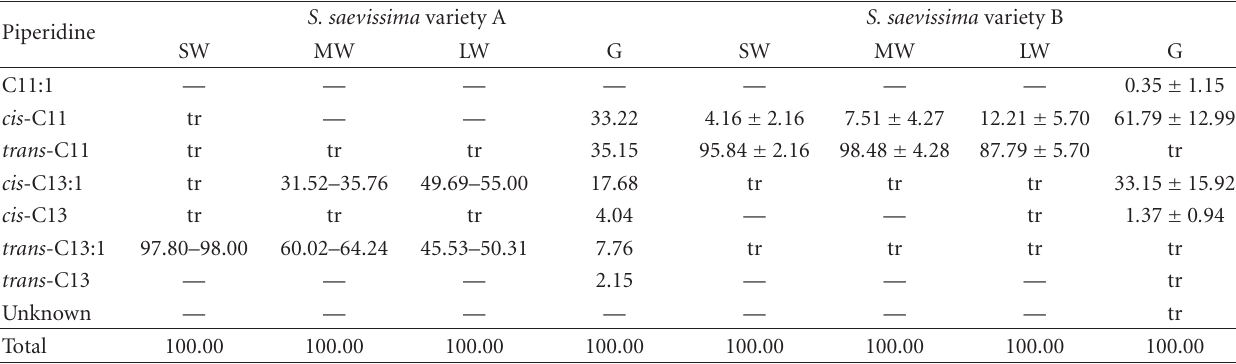
Table 4: Relative abundance (%) of piperidinic alkaloids obtained from hexane extracts of small workers (SWs), medium workers (MWs), and major workers (LWs) and gynes (Gs) from di ff erent nests of Solenopsis saevissima varieties A ( n = 3) and B ( n = 4) from Pedro do Rio, Rio de Janeiro state, Brazil.